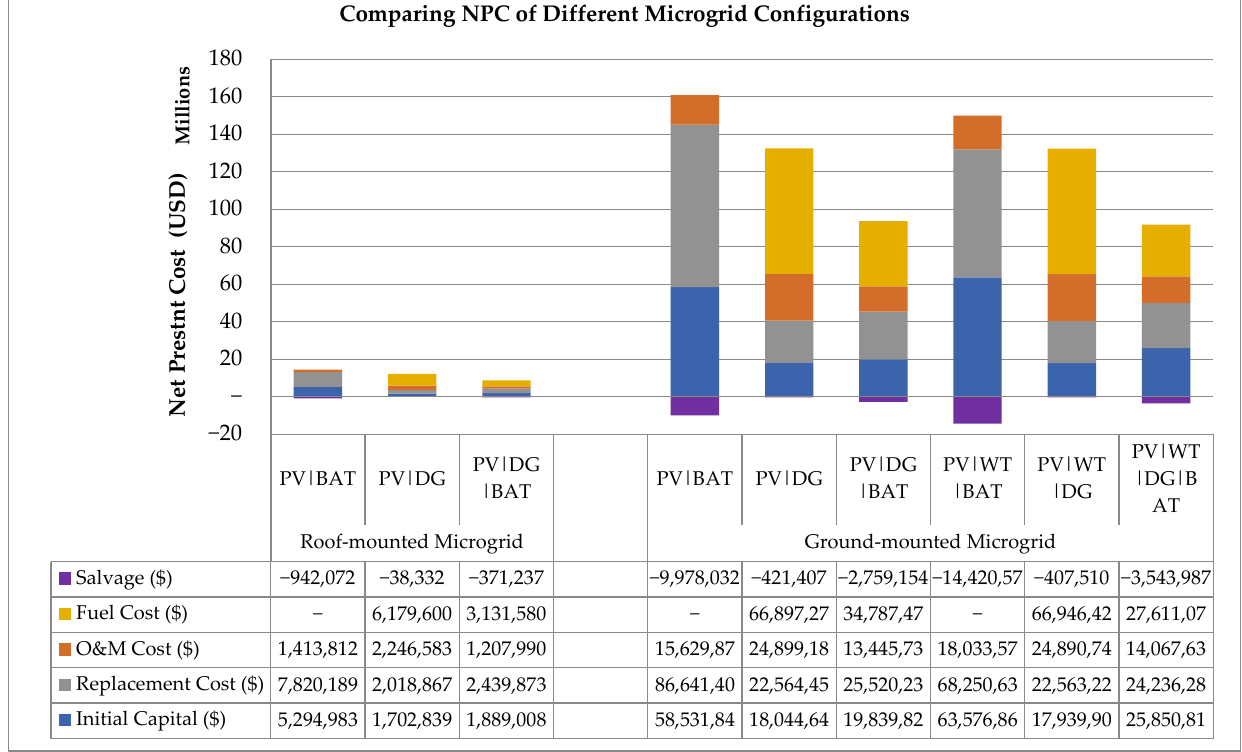
Figure 14. Comparing costs of different microgrid system configurations. Table 8. Techno-economic comparison of different energy system configurations *.